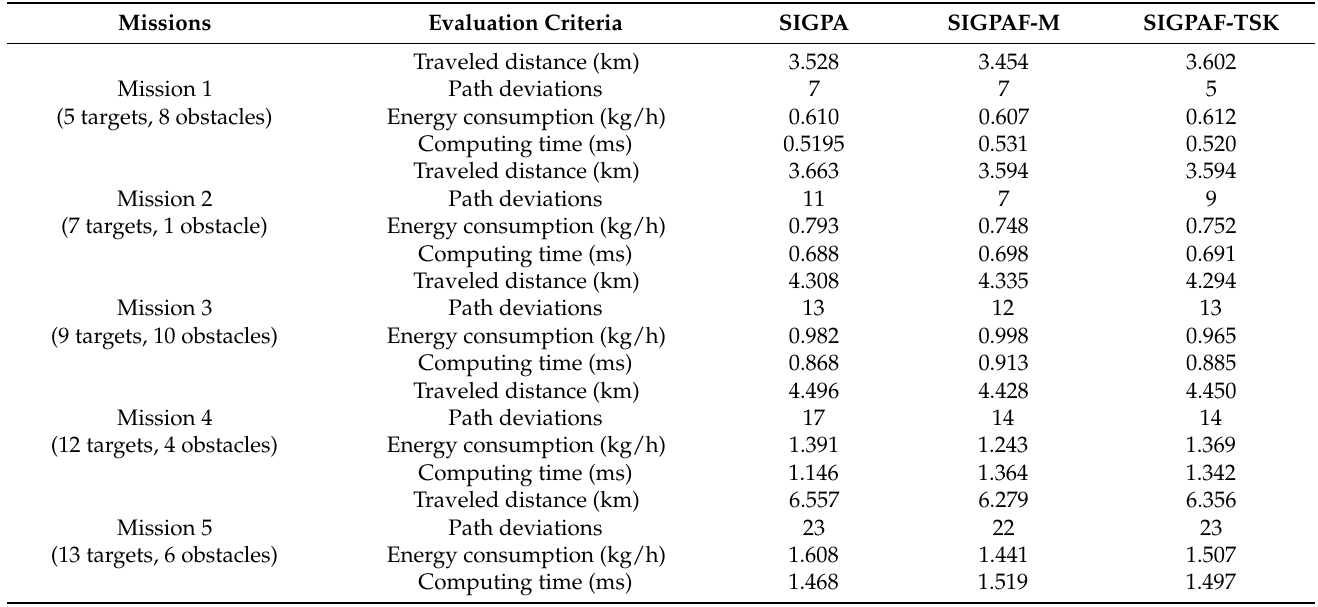
Table 4. Experimental results of 10 random generated scenarios of SIGPA, SIGPAF-M, and SIGPAF-TSK.